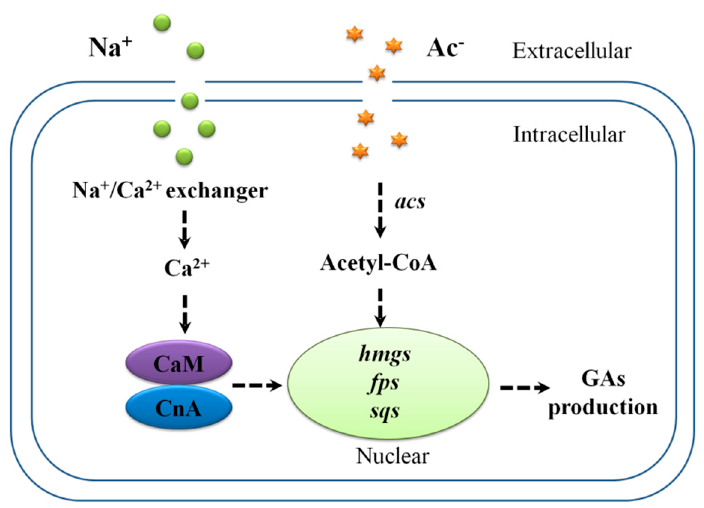
Figure 8. Schematic pathway predicting the role of sodium acetate-induced genes in G. lucidum . Dashed lines indicate steps consisting of multiple enzyme reactions. CaM, calmodulin; CnA, calcineurin subunit A; acs , acetyl-CoA synthetase; hmgs , hydroxymethylglutaryl-CoA synthase; fps , farnesyl pyrophosphate synthase; sqs , squalene synthase; GAs, ganoderic acid. Symbols: increasing effect.